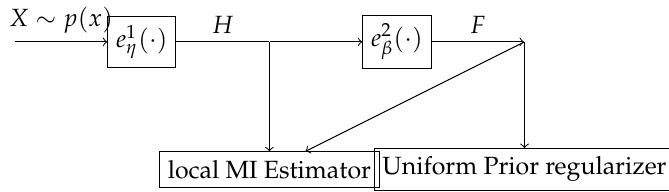
Figure 3. High level scheme of architecture used in this work.